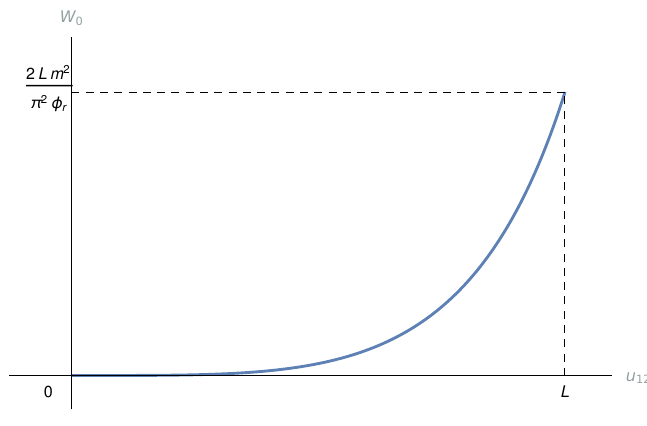
Figure 21 . The connected part of the in-order four-point